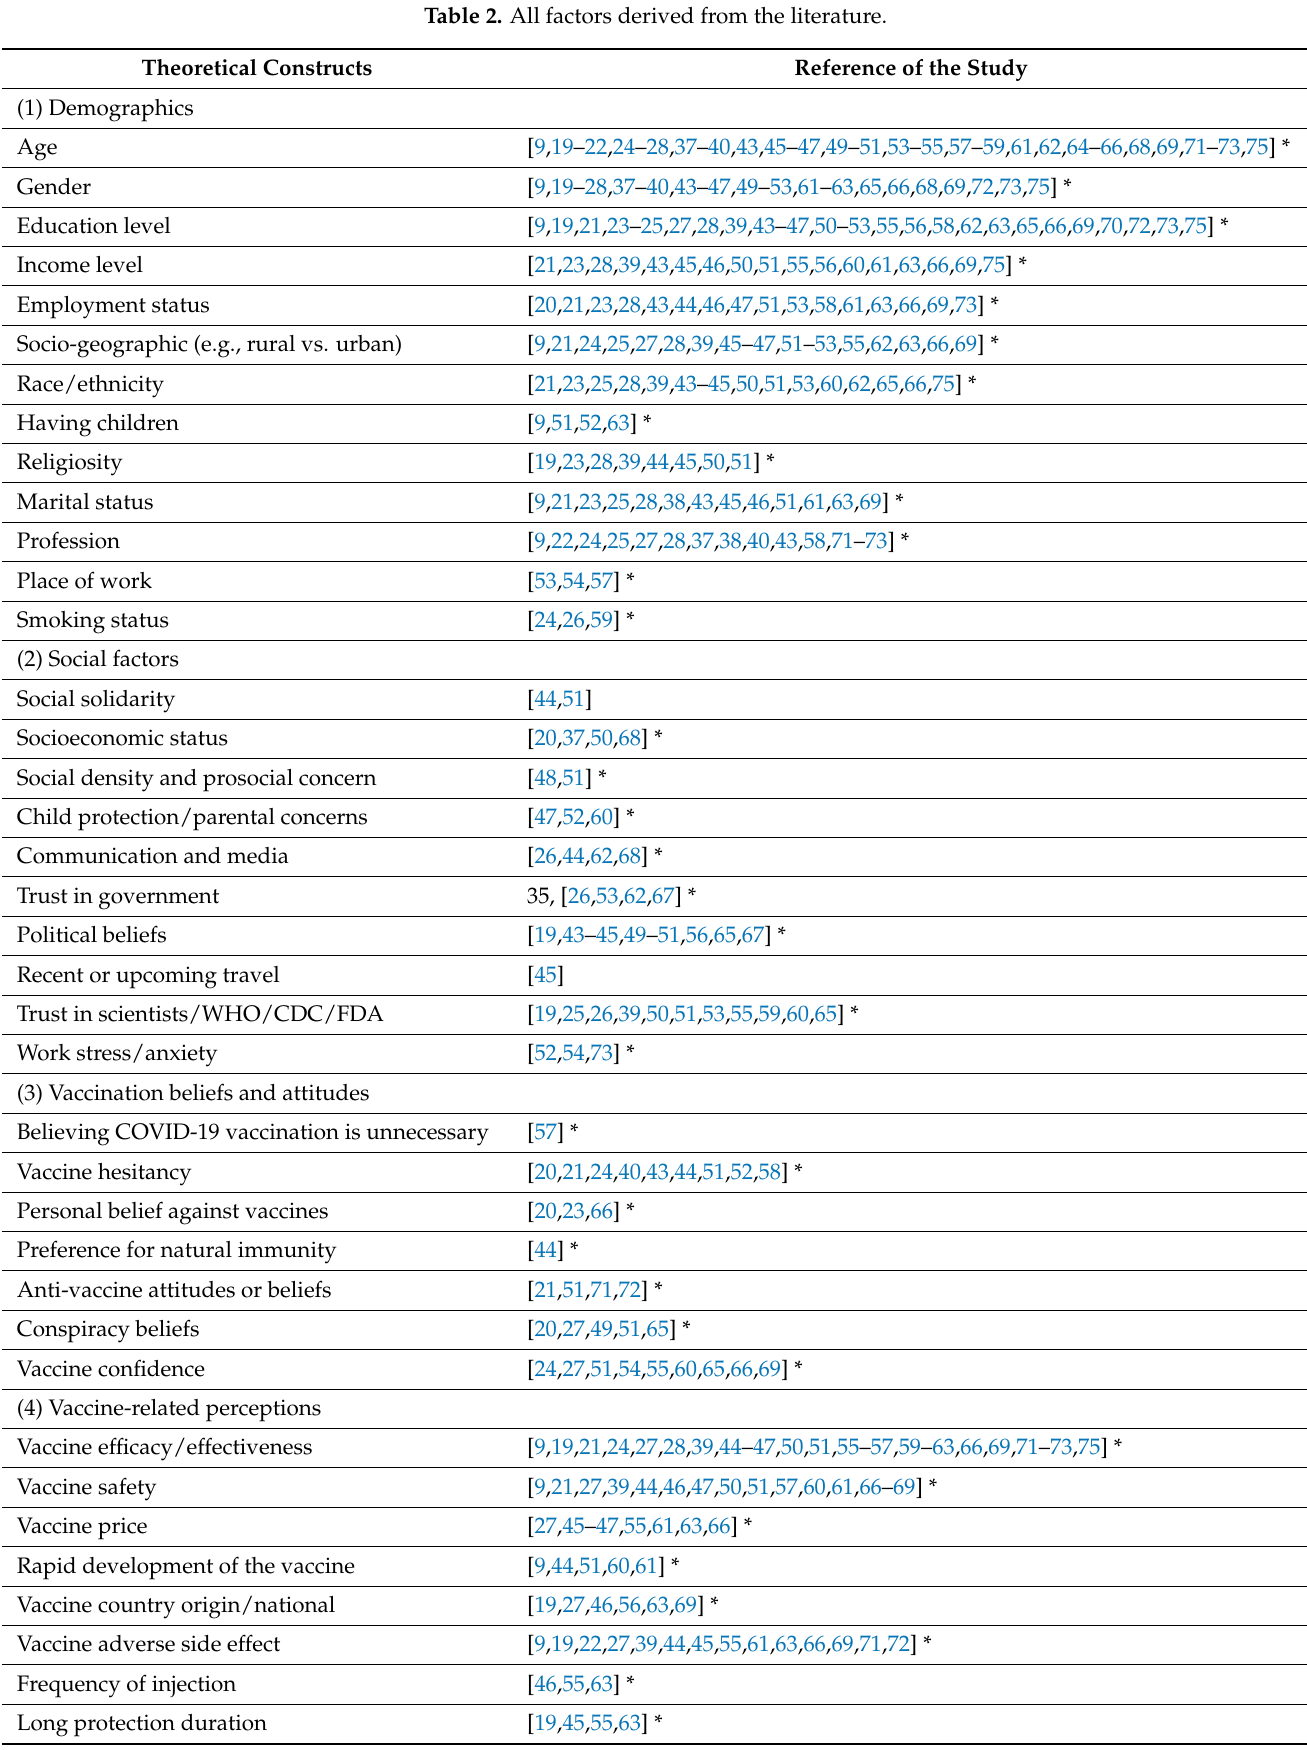
Table 2. All factors derived from the